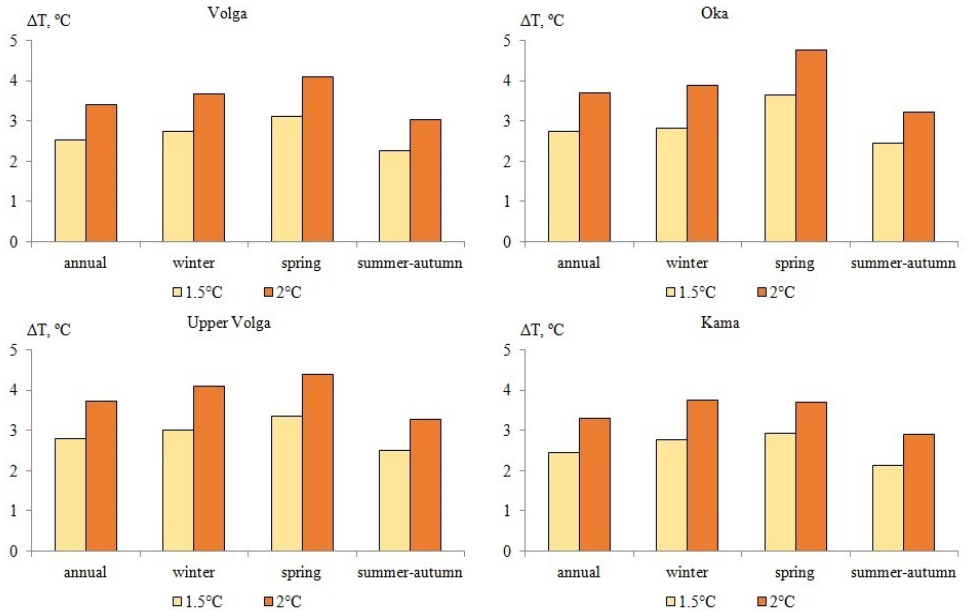
Figure 5. Anomalies of mean annual and seasonal air temperature in the Volga basin under global warming by 1.5 °C and 2 °C degrees in the 21st century relative to the baseline period 1970–1999. The increase in annual precipitation in the Volga basin was 8% under global warming by 1.5 °C, and the increase in precipitation varies from 10% in the Oka basin to 13% in the Kama basin under global warming by 2 °C, with the average value of 11% in the Volga basin (Figure 6). The relative increase in winter precipitation in the Volga basin was 13% and 18% under global warming by 1.5 °C and 2 °C, respectively; spring precipitation in- creased by 4% and 11%, respectively; and summer and autumn precipitation increased by 6% to 7%. Winter precipitation in the Upper Volga will increase by 2% more and in the Oka by 2% less relative to the average value in the Volga basin. The most intense increase in precipitation is characteristic of the Kama basin by 9% and 18%, depending on the warming scenario.